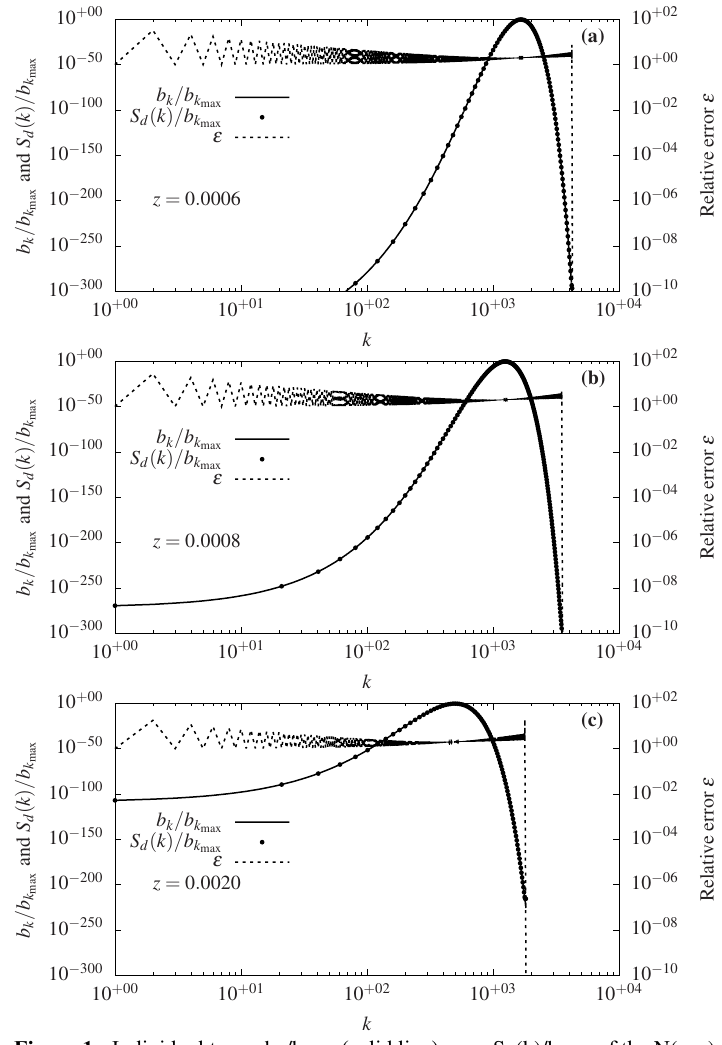
Figure 1 - Individual terms b k /b k (solid line), sum S d (k)/b k of the N(z; α ) max max series (filled circles), and relative error ε (dashed line) with α = –1/2 , θ = –1/2 . (a) z = 0.0006 , (b) z = 0.0008 and (c) z = 0.0020 . Only (c) converged to the correct value with less than 10000